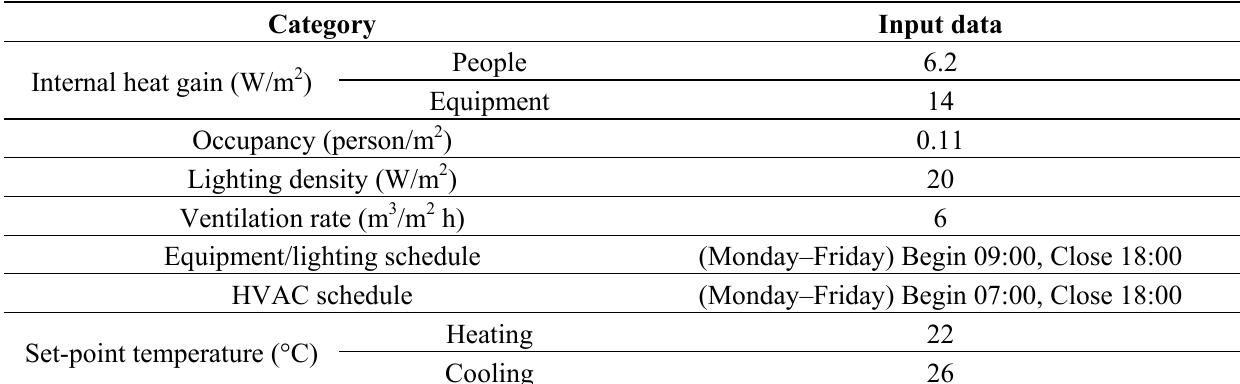
Table 2. General input data.